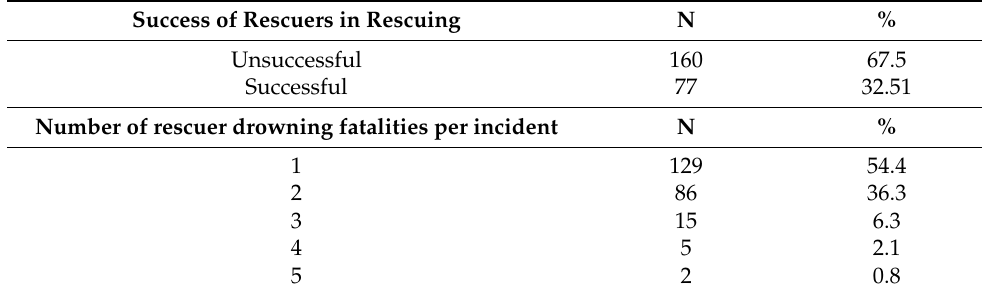
Table 3. Success of rescuers in rescuing and number of multiple drowning incidents.